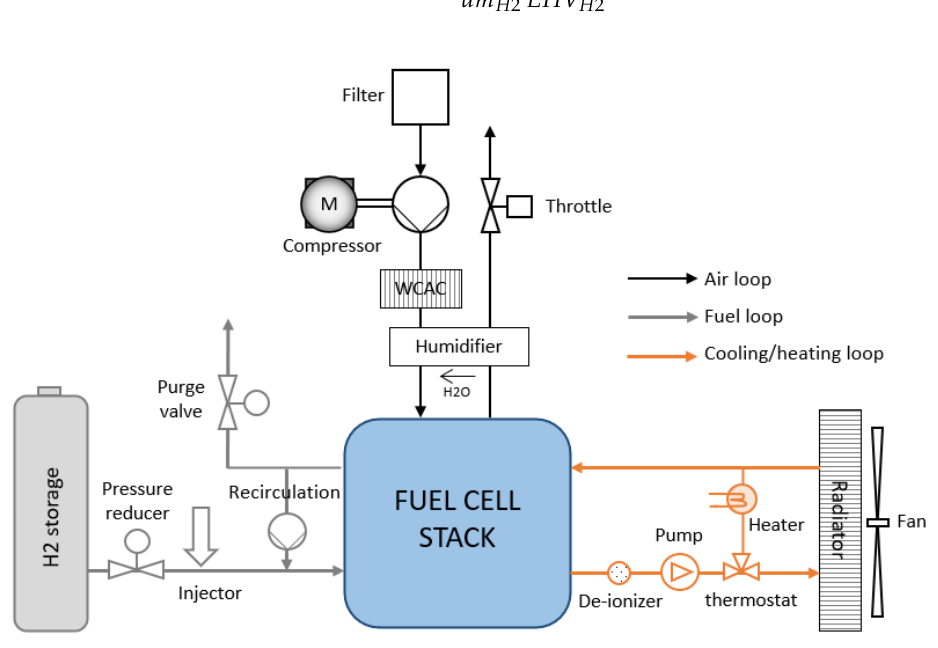
Figure 8. Balance of plant subsystems supporting functioning of the fuel cell stack include air, fuel and thermal management